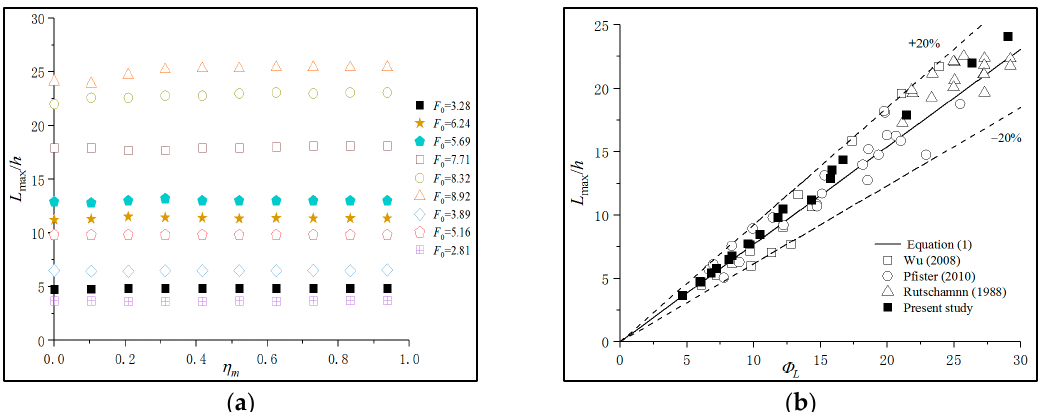
Figure 2. The jet length. ( a ) Jet length at different atmospheric pressures; ( b ) the data compared with Equation (1).